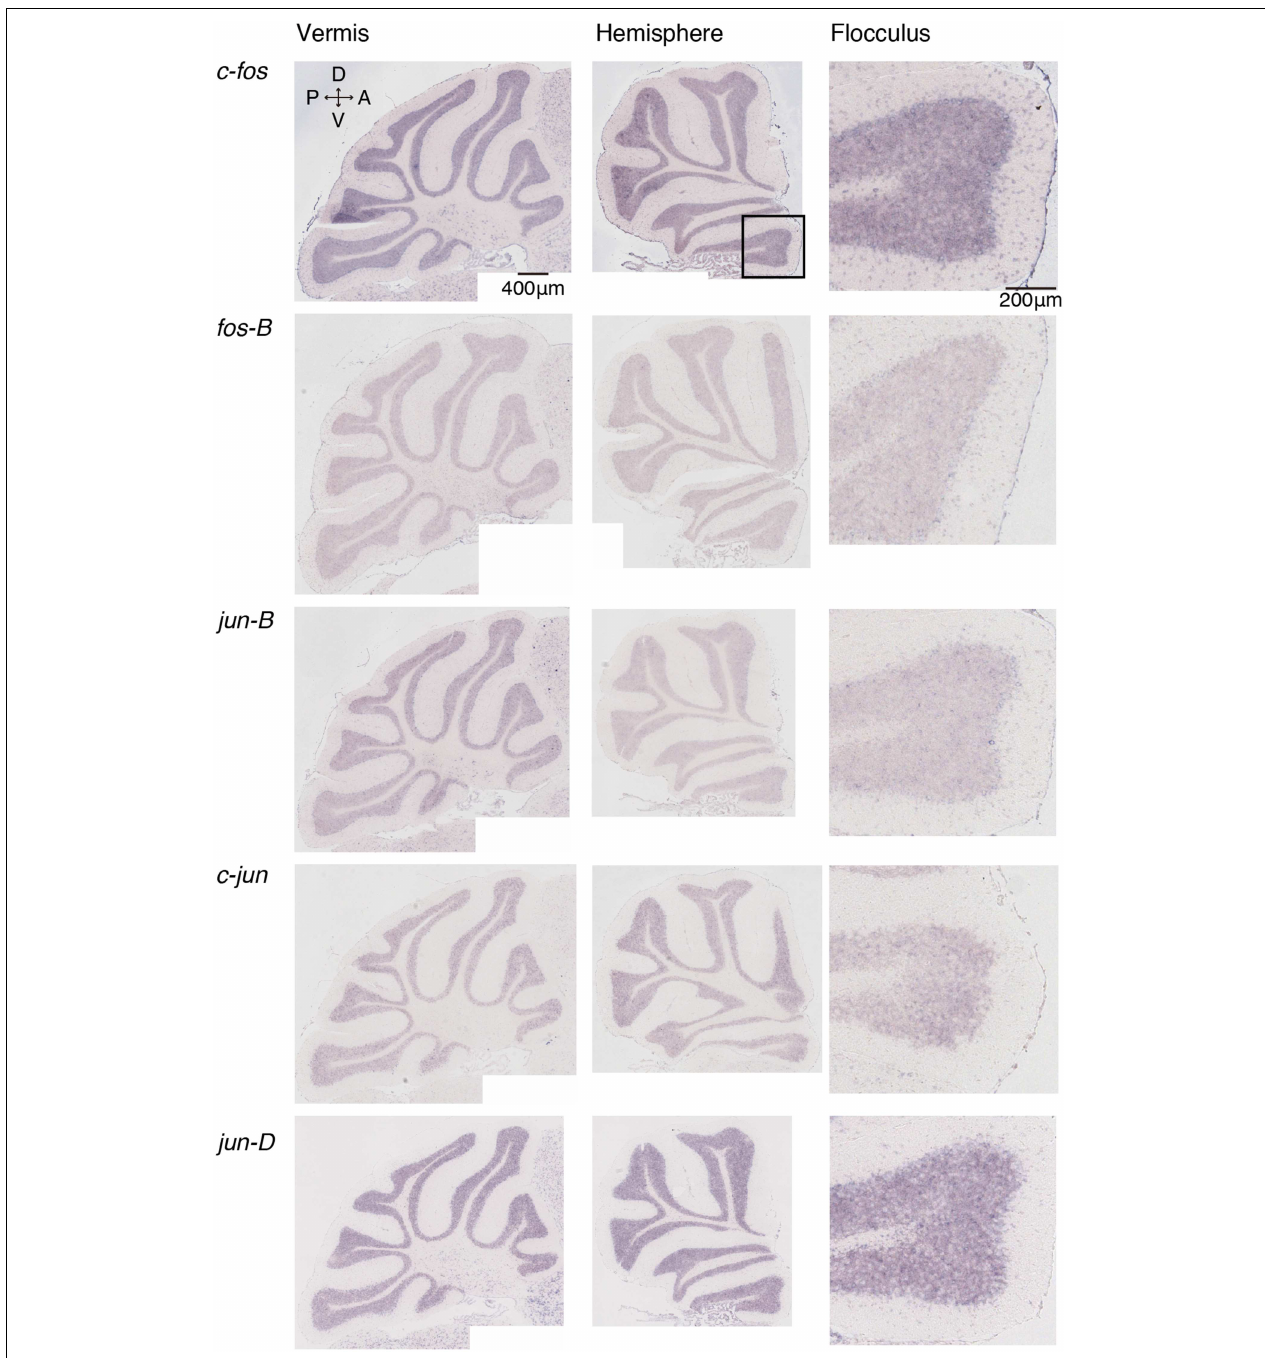
showing flocculus ( right panel ). Each row shows expression patterns of eight IEGs (from top to bottom: c-fos, fos-B, jun-B, c-jun, jun-D